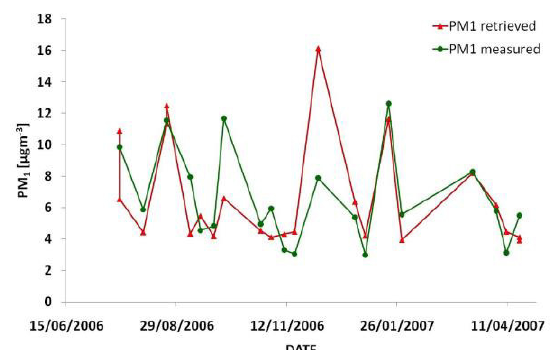
Figure 4. Comparison between retrieved and measured PM 1